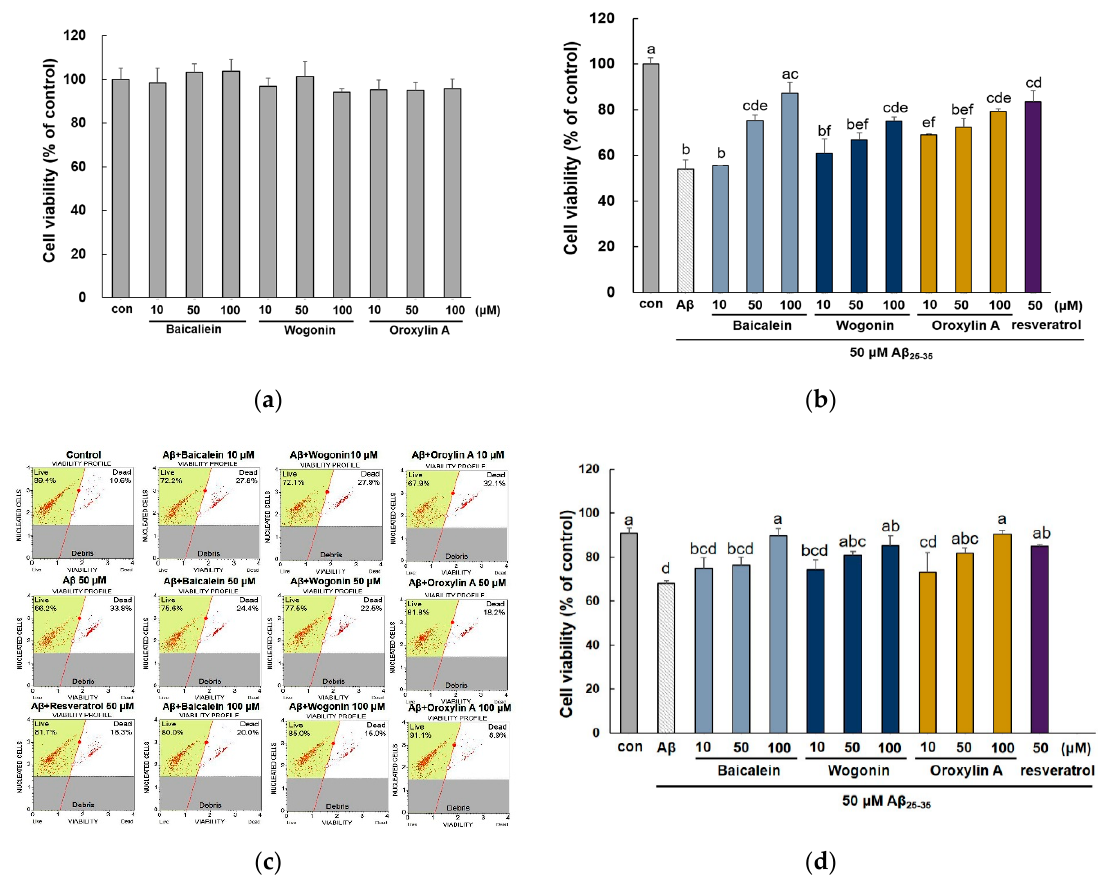
Figure 2. Protective effects of baicalein, wogonin, and oroxylin A in A β 25–35 -treated PC12 cells.